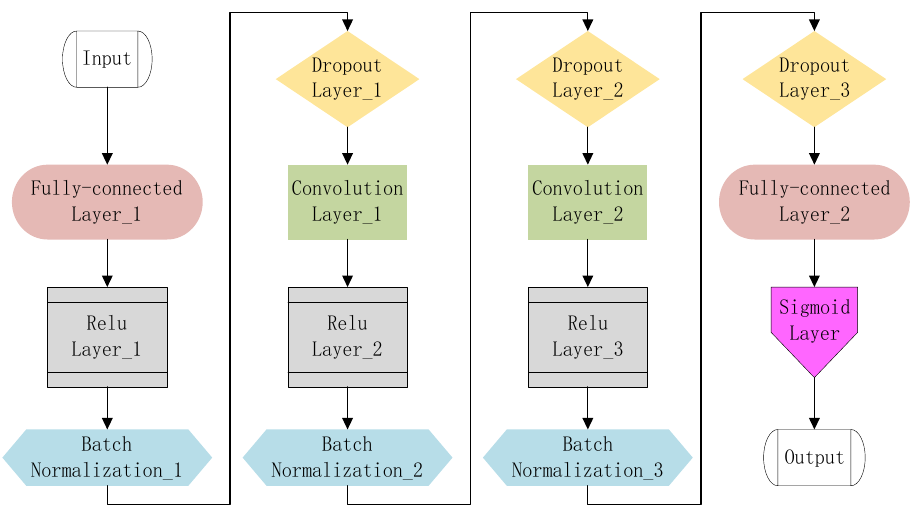
Figure 7. Illustration of network structure.